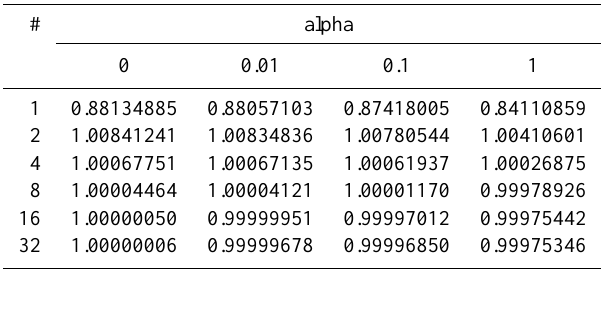
Table 6. First non-dimensionalized eigenfrequency analysis for a simply supported beam with pre-stress in Sect. 6.7 versus number (#) of finite elements.